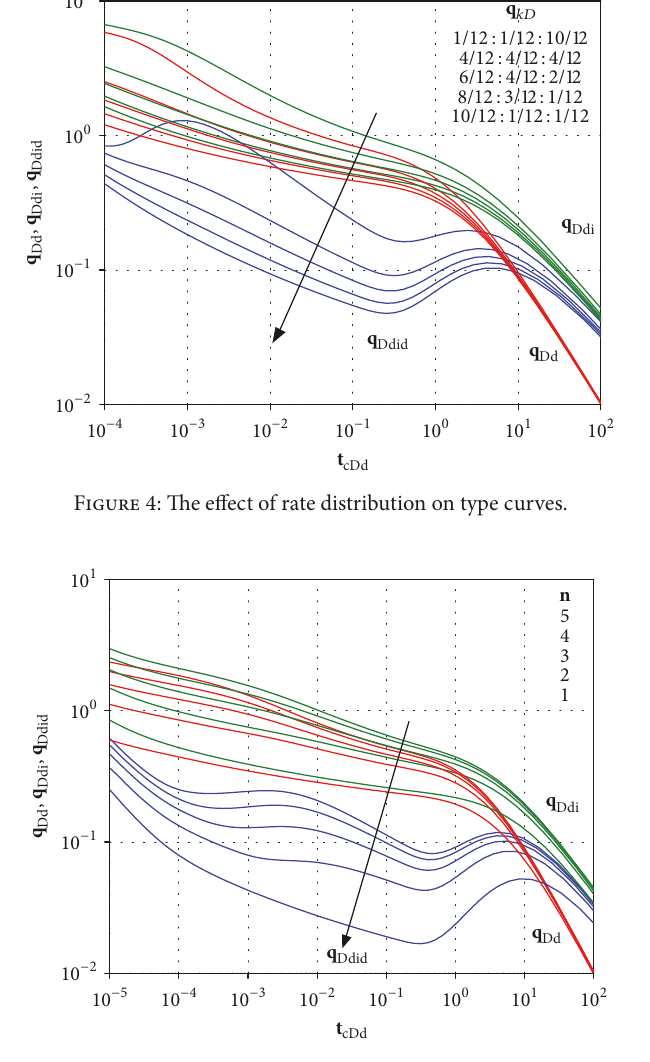
Figure5:Theeffectofnumberofhorizontalsectionsontypecurves.